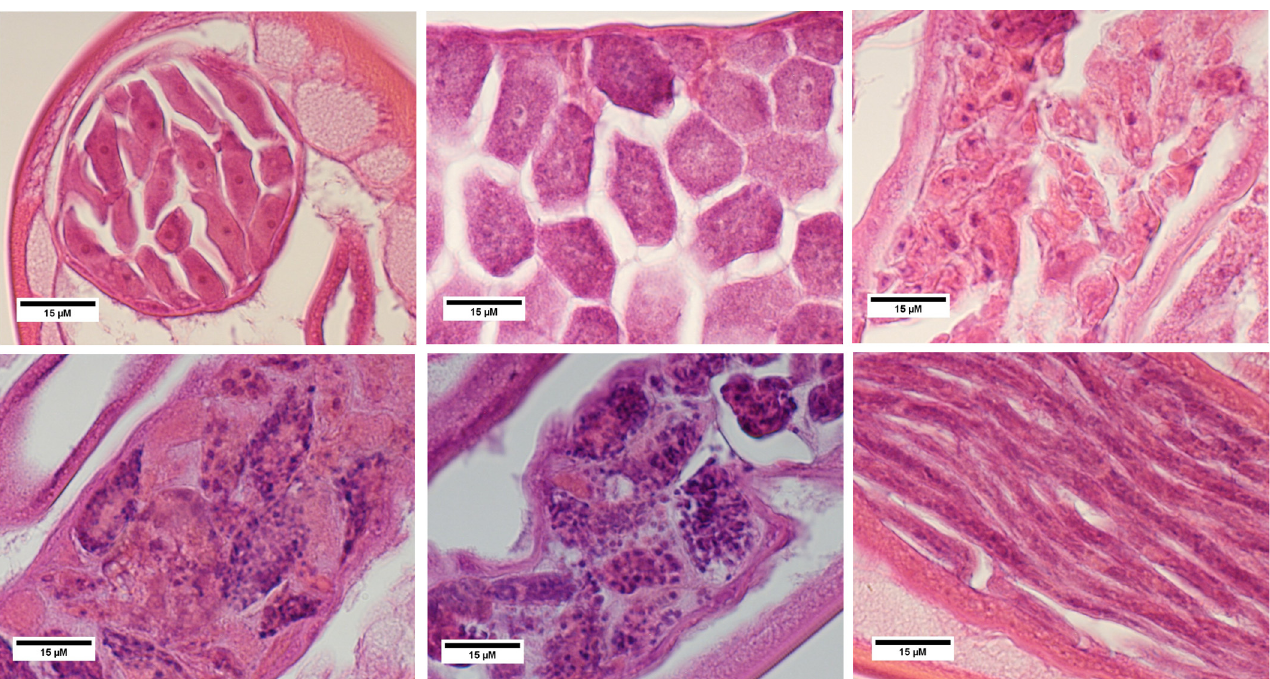
Fig 4. Long-term effects of FLBZ on developing embryos. Exposure period was 24 hr in culture prior to re-implantation. Time to recovery after transplant was 4 weeks. A. Oocytes, DMSO control; B. Morulae, DMSO control; C. Oocytes, 100 nM; D. Early Morulae, 1 μ M; E. Late Morulae, 100 nM; F. Microfilariae, 10 μ